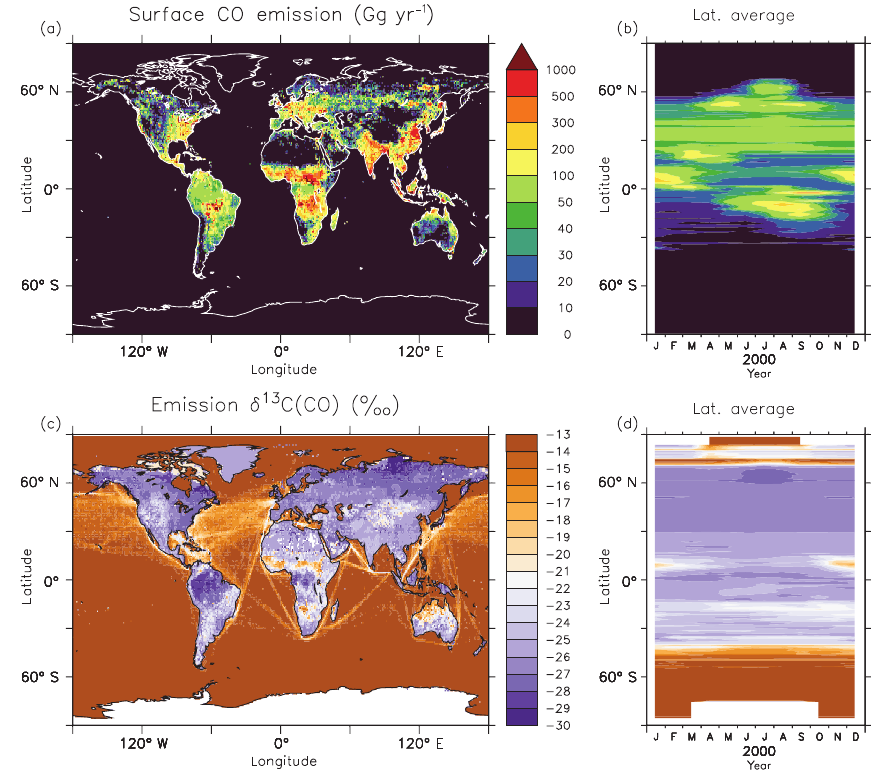
Figure 7. (a, c) Annual CO emission from the surface sources (a) and corresponding carbon isotopic composition (c) . (b, d) Respective time series of zonal averages for the year 2000 emission with identical colour scale.